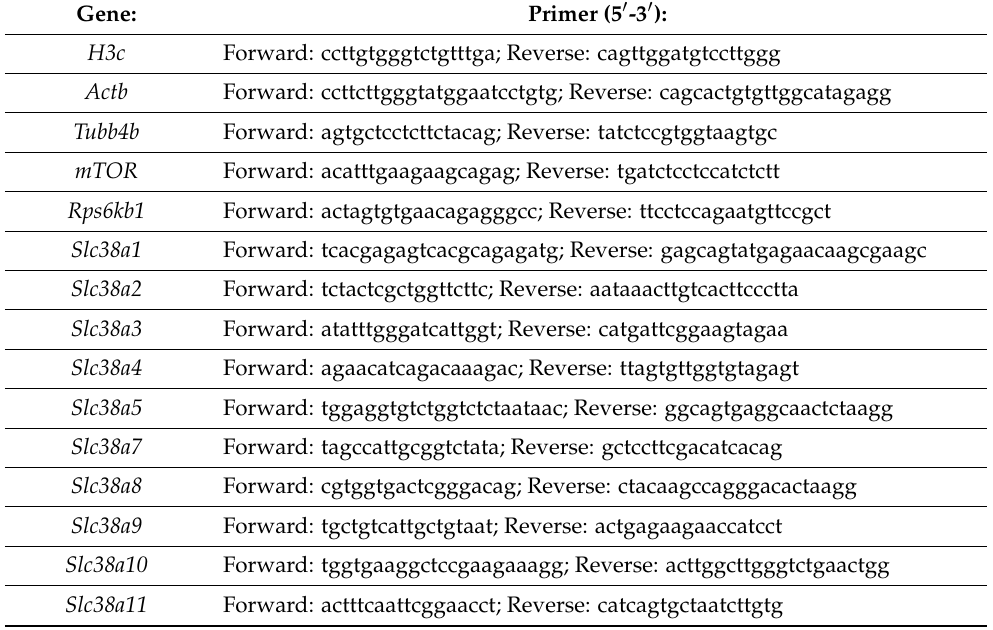
Table 1. Primer sequences used in